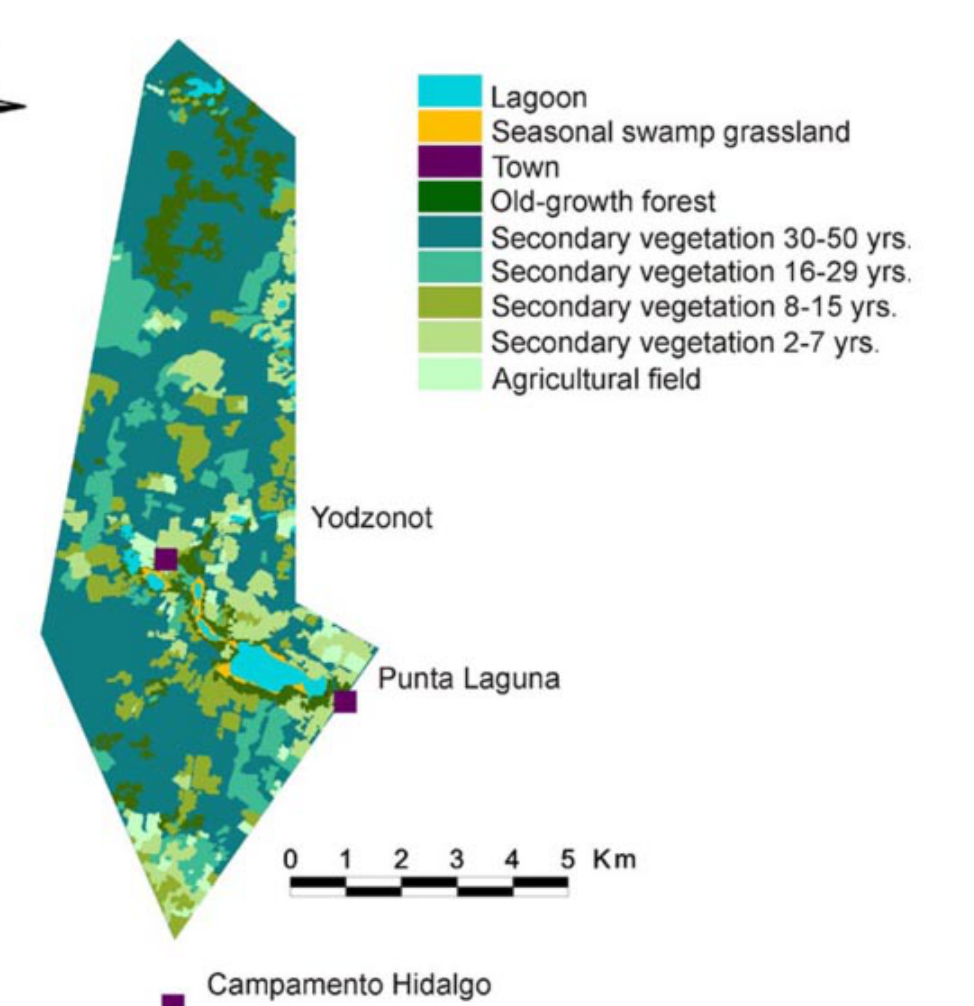
Fig. 2. Vegetation map of the Otoch Ma’ax Yetel Kooh (OMYK) Flora and Fauna Protected Area in